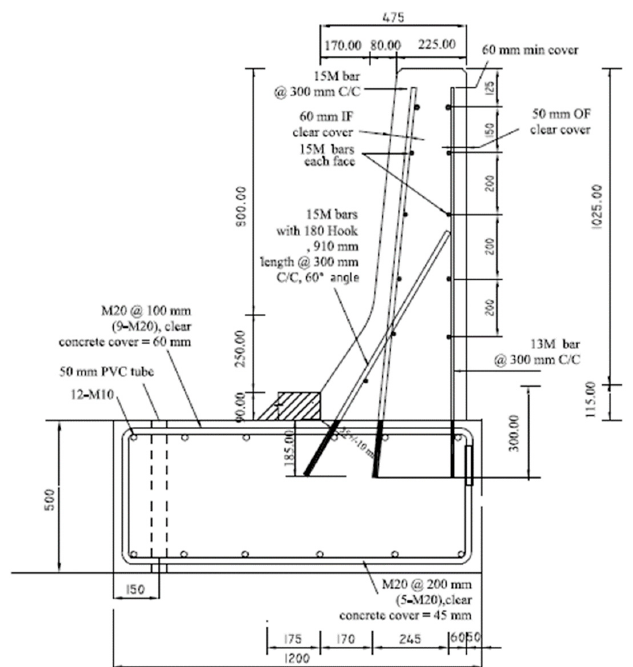
Figure 6. Specimen # 4: Interior location of barrier connected to a non-deformable slab.